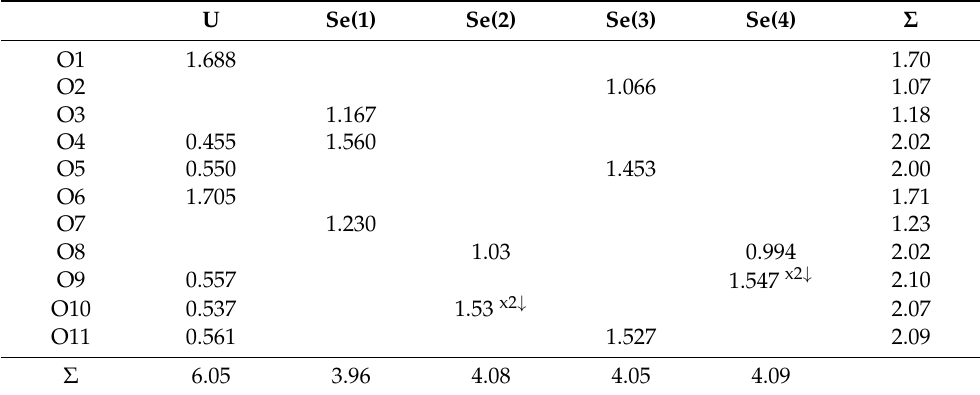
Table 5. BVS calculations for (UO 2 ) 2 (HSeO 3 ) 2 (H 2 SeO 3 ) 2 Se 2 O 5